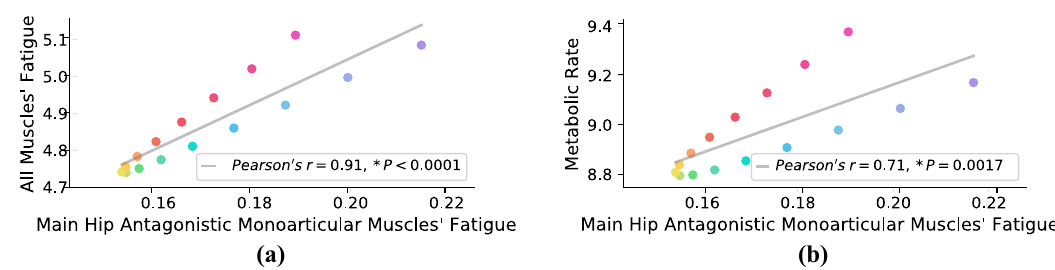
Figure 7. ( a ) is the correlation between all muscles’ fatigue and two antagonistic mono-articular hip muscles’ fatigue, and ( b ) is the correlation between metabolic rate and two antagonistic mono-articular hip muscles’ fatigue; the color of each point in this plot is the same with its column color in Fig. 6. The P value for ( a , b ) are P < 0.0001 and P = 0.0017 , and ”Pearson’s r-value” are r = 0.91 and 0.71. Both figures show a certain linear correlation between the parameters. Interestingly, for both figures, near to the optimum spring coefficient, the deviations from the linear estimation are minimum, and by getting away from the optimum stiffness coefficient, the deviations